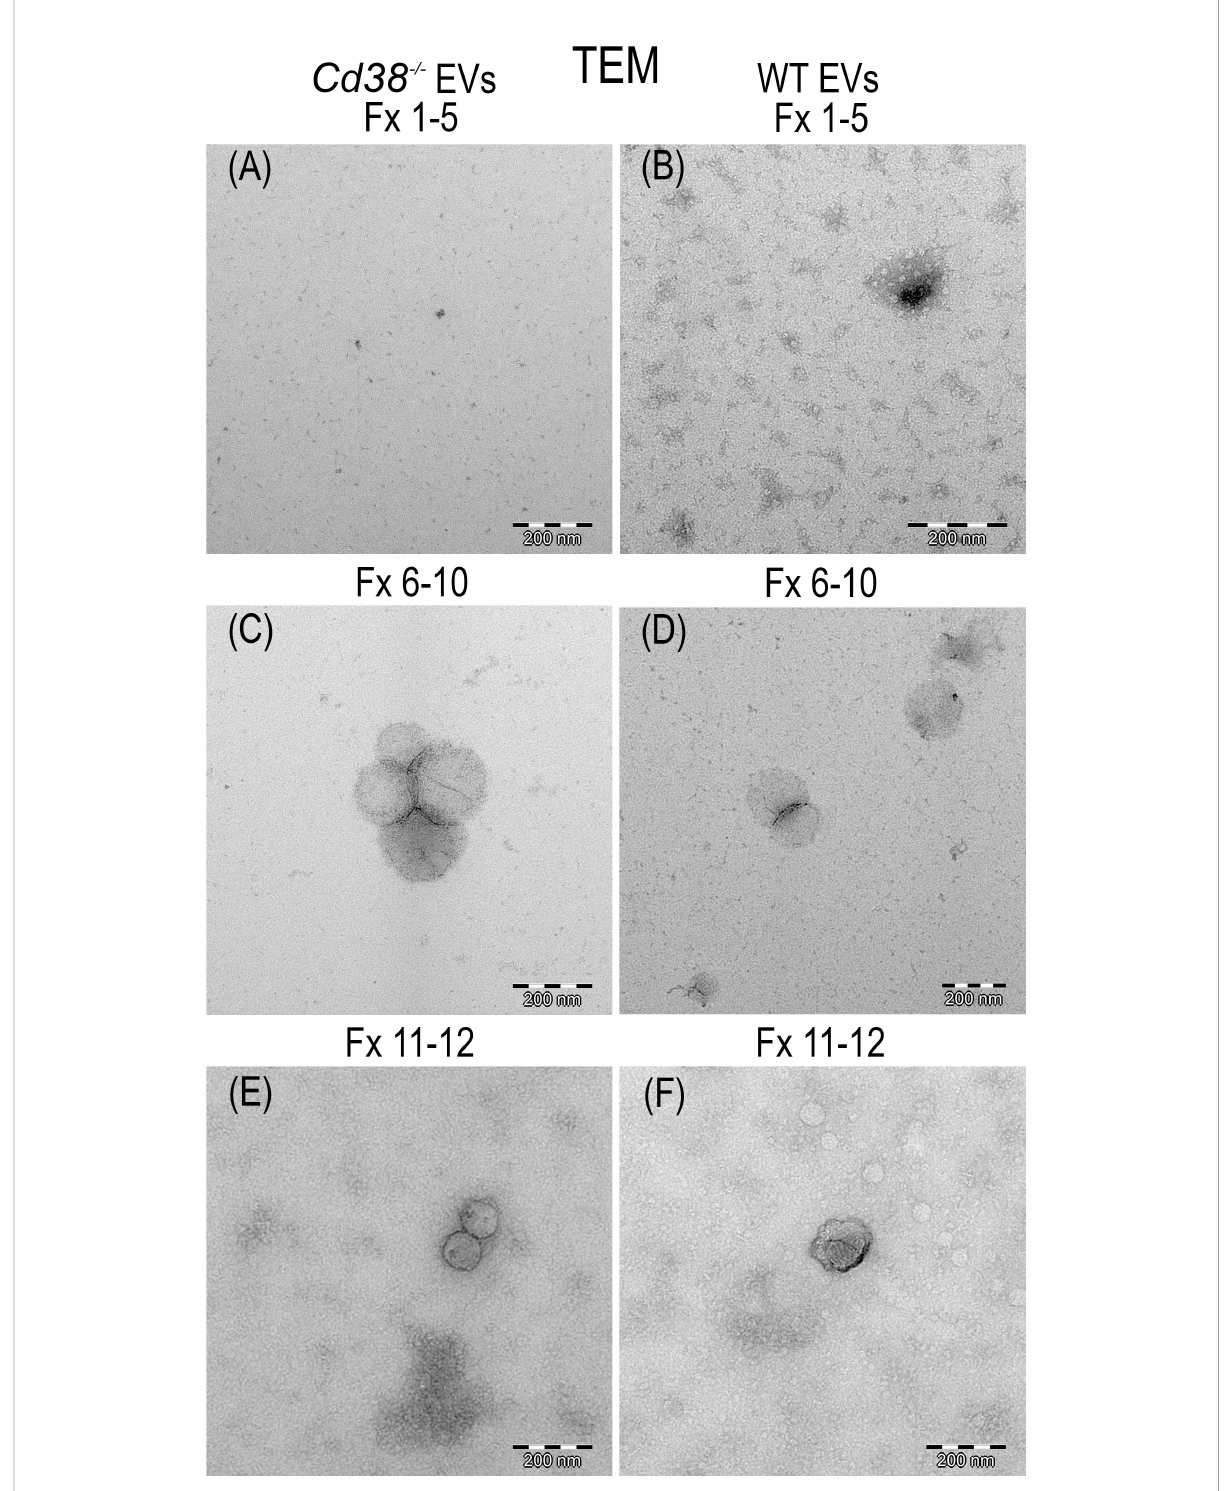
FIGURE 2 Transmission electron micrograph photos of SEC pooled fractions of supernatants from peritoneal exudates of 2wks pristane-treated Cd38 -/- mice (A, C, E) or WT mice (B, D, F) . F1-5 showed only grid background (A, B) . F6-10, vesicles were easily identi fi ed (C, D) . F11-12, vesicles of smaller size than in F6-10 were more frequently observed. EV, negatively stained, appeared dark; LPPs appeared